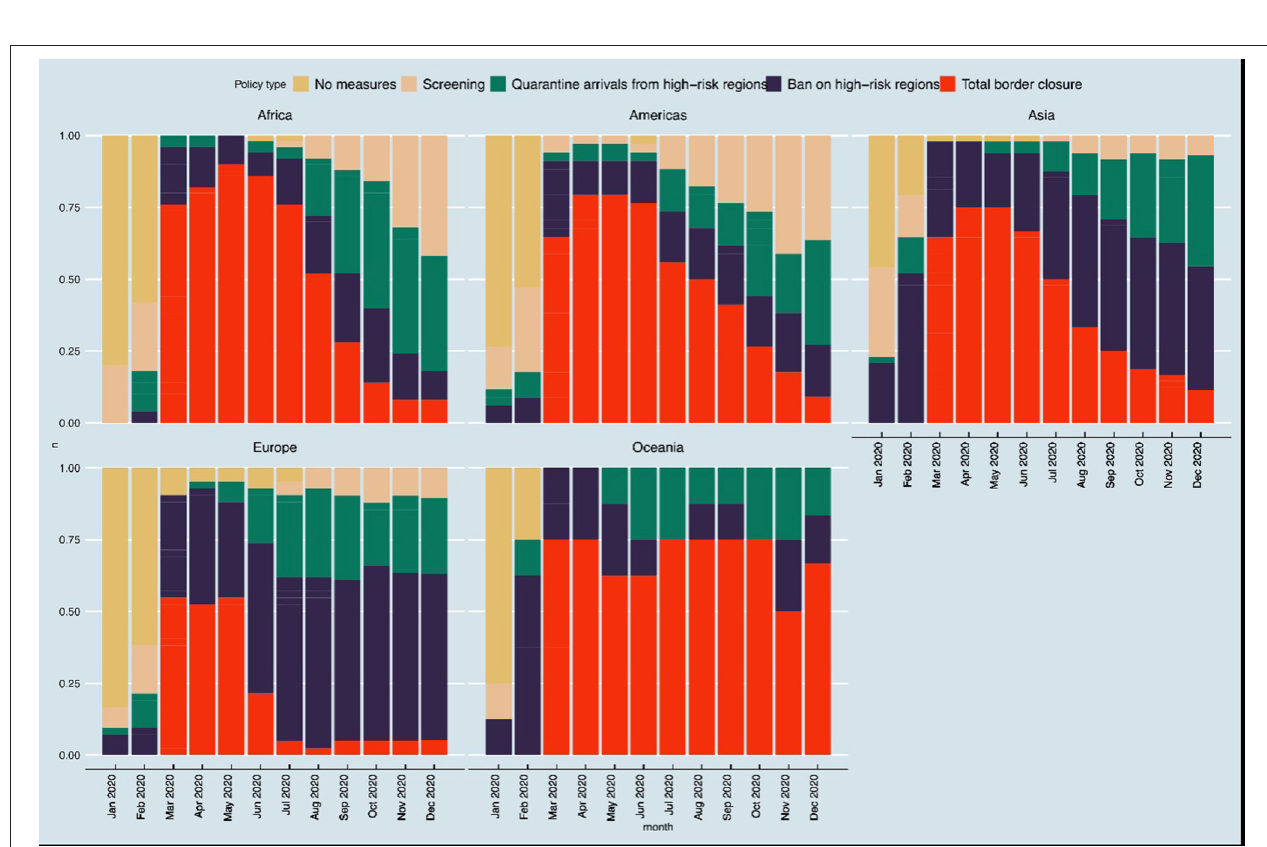
FIGURE 4 | Trends in international travel controls